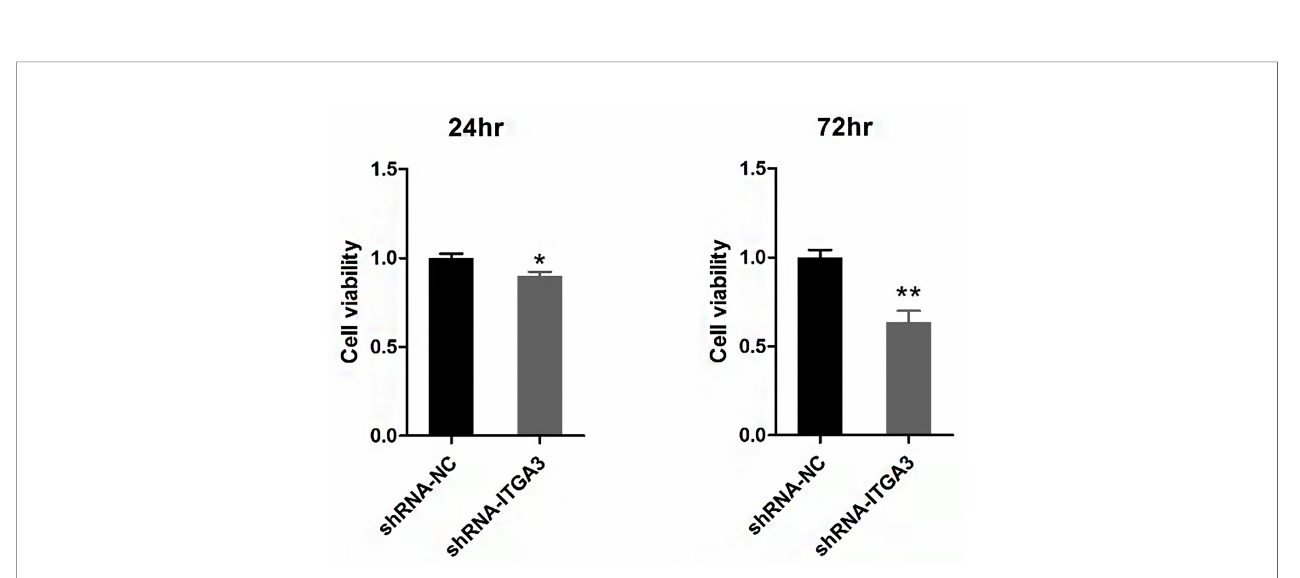
FIGURE 10 | Viability analysis of BCPAP cells with CCK8 assay (**P < 0.01, *P < 0.05, compared with negative